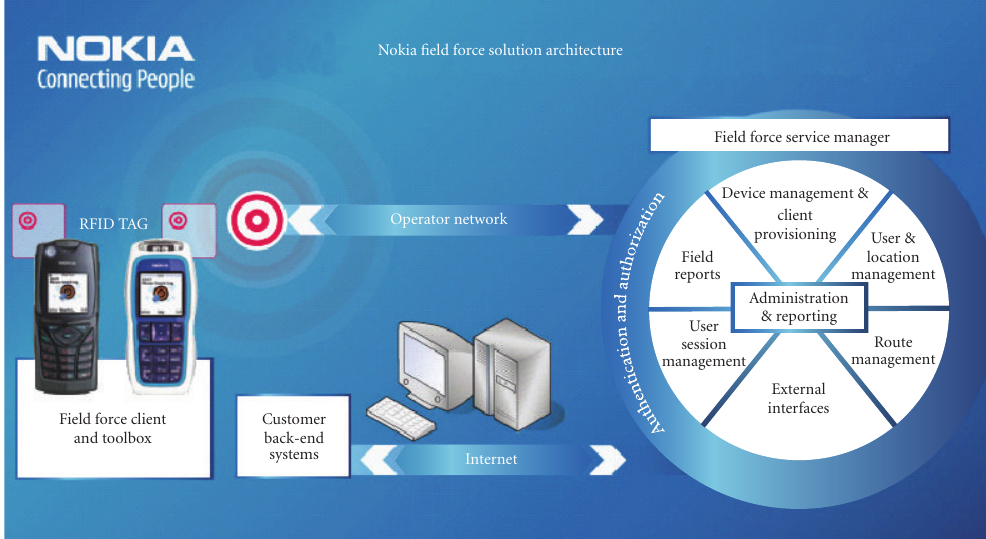
Figure 1: Nokia FFS architecture